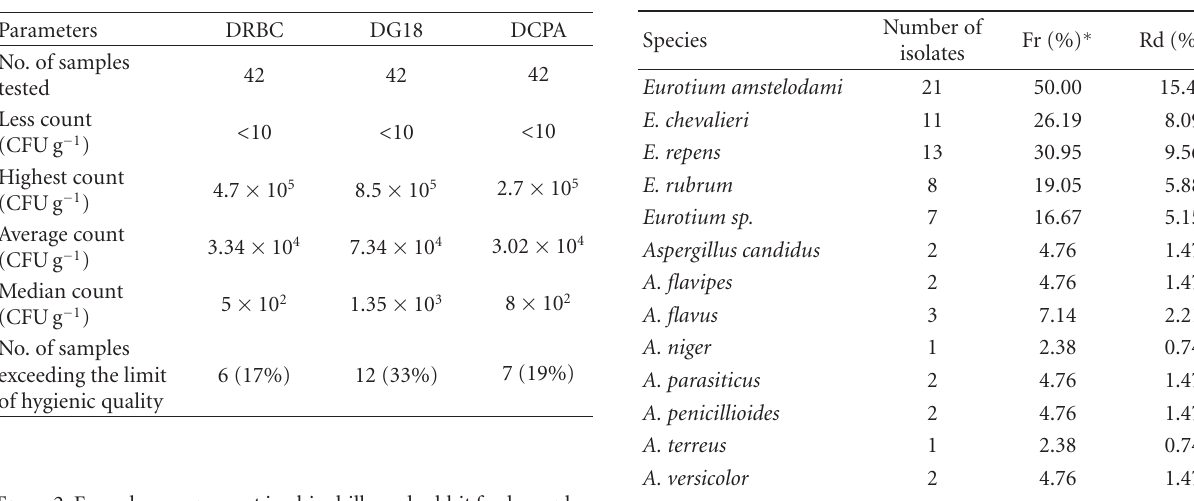
Table 3: Fungal species present in chinchilla and rabbit feed sam-